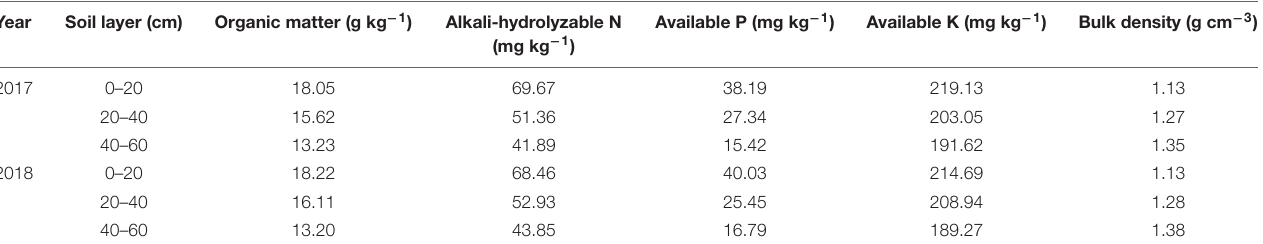
TABLE 1 | Basic physicochemical properties of the experimental